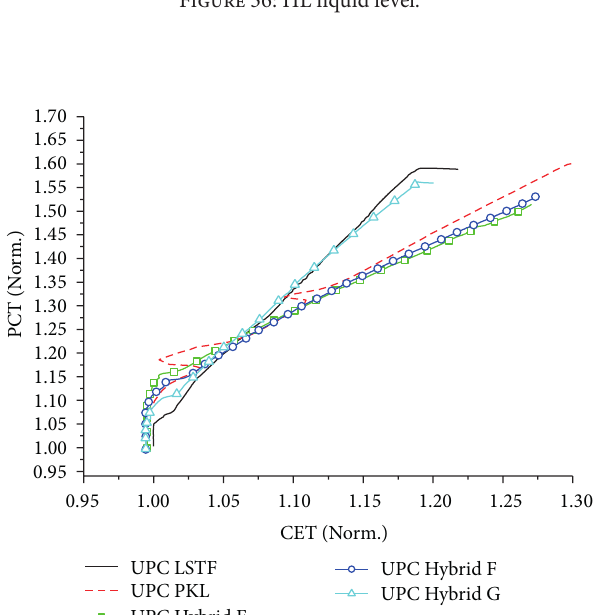
Figure 36: HL liquid level.